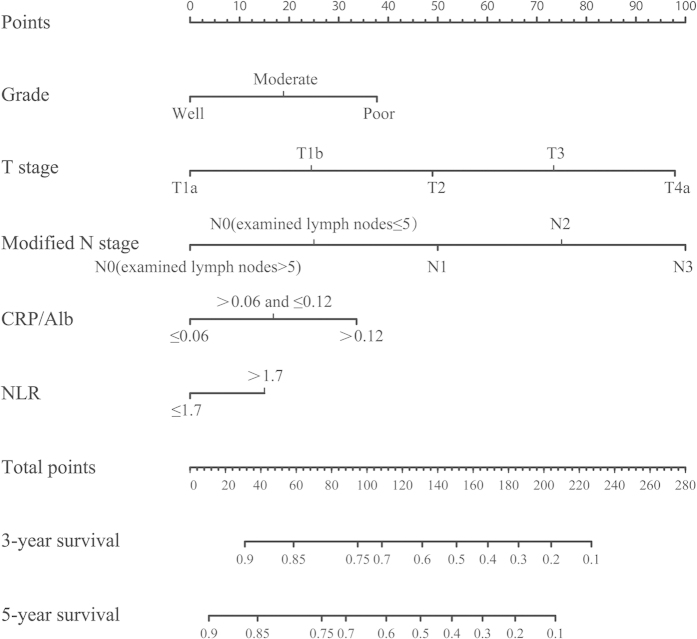
Evaluation of nomogram integrated systemic inflammation scores in the patients with esophageal squamous cell cancer after radical esophagectomy.To use the nomogram, the value attributed to an individual patient is located on each variable axis, and a line is drawn upwards to determine the number of points received for each variable value. The sum of these numbers is located on the total points axis, and a line is drawn downward to the survival axis to determine the likelihood of 3- or 5-year survival. CRP/Alb, C-reactive protein/albumin; NLR: neutrophil lymphocyte ratio.